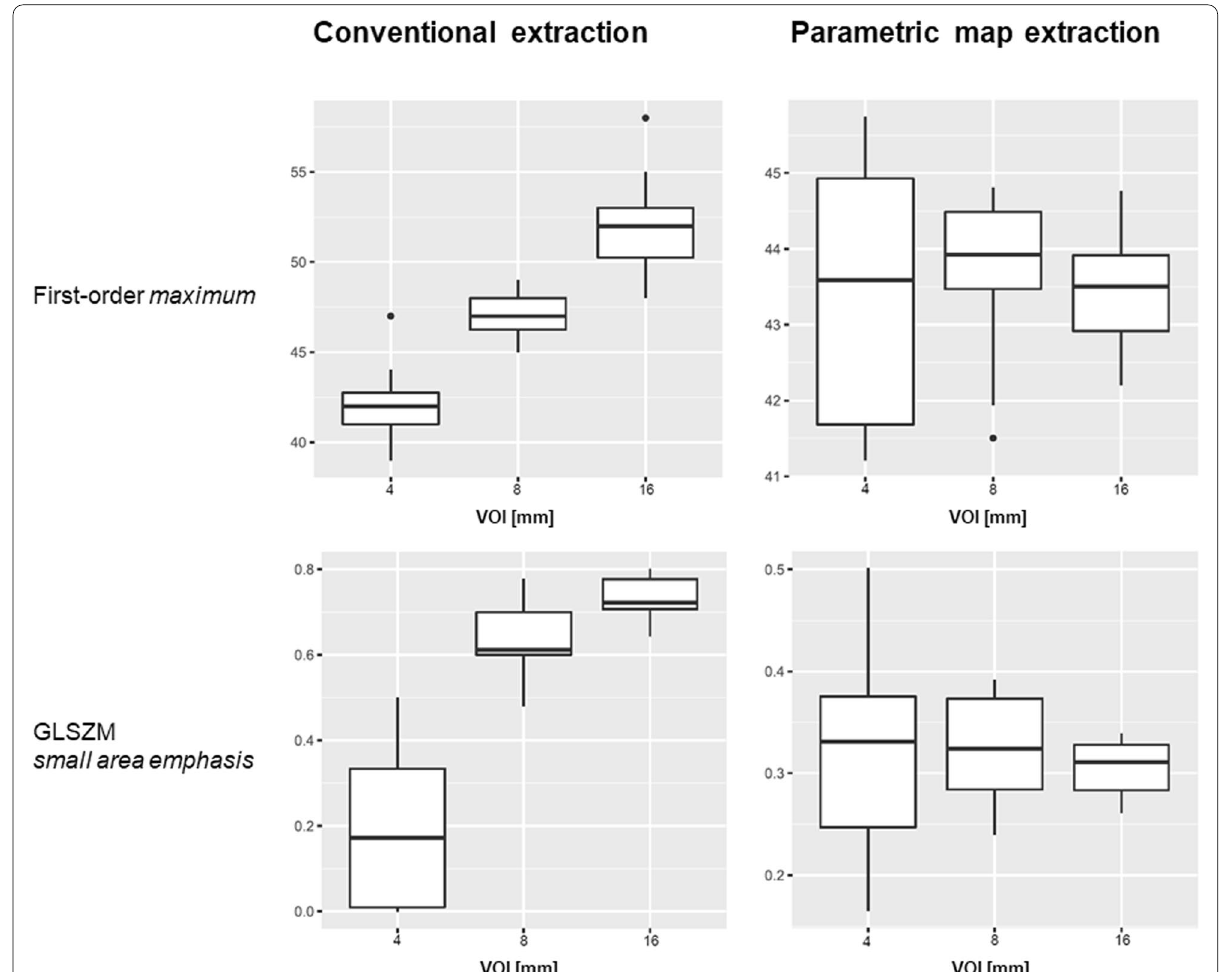
Fig. 3 Boxplots of features extracted conventionally and from parametric maps. Exemplary boxplots of the first‑order feature maximum and the higher‑order feature GLSZM small area emphasis across the different volume‑of‑interest (VOI) sizes. The left column shows boxplots of the conventional feature extraction with a wide variety of results across the VOI sizes, affecting the median. The same features are shown on the right, but values were retrieved from the parametric maps. Please also note the range on the y ‑axis. Boxplots for all features are provided in the Supplementary material (Fig. S6 contains boxplots of conventionally extracted features and Fig. S7 of extraction from parametric